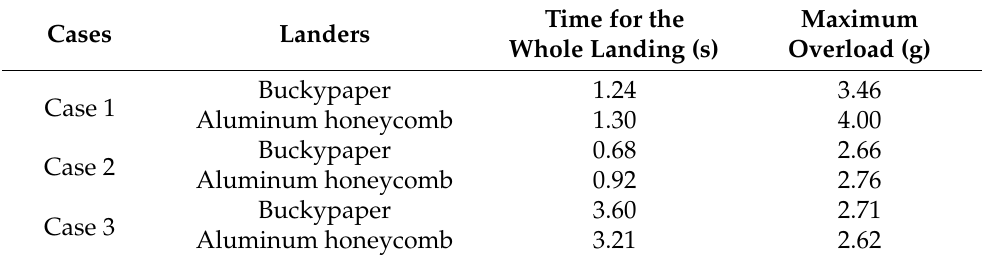
Table 7. Important data about the center-of-mass overload